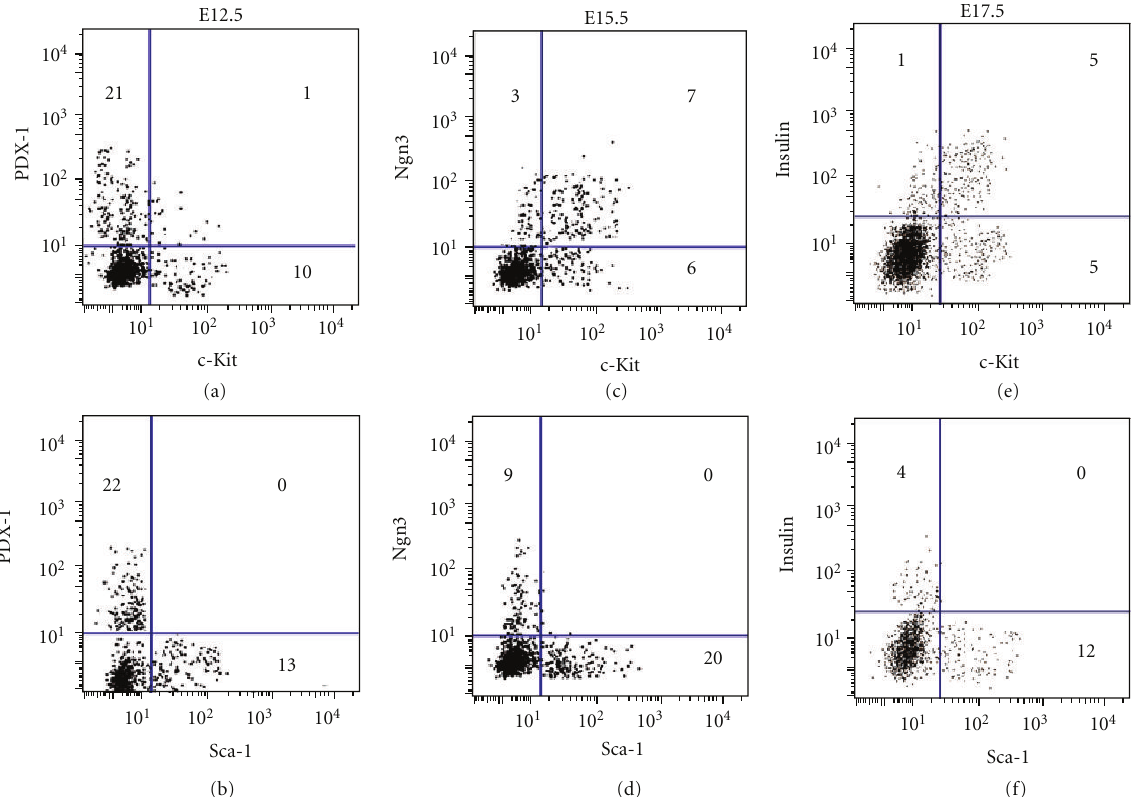
Figure 3: The coexpression of Sca-1 and c-Kit with PDX-1, Ngn3, and insulin in embryonic pancreas at E12.5, E15.5, and E17.5 by flow cytometry.